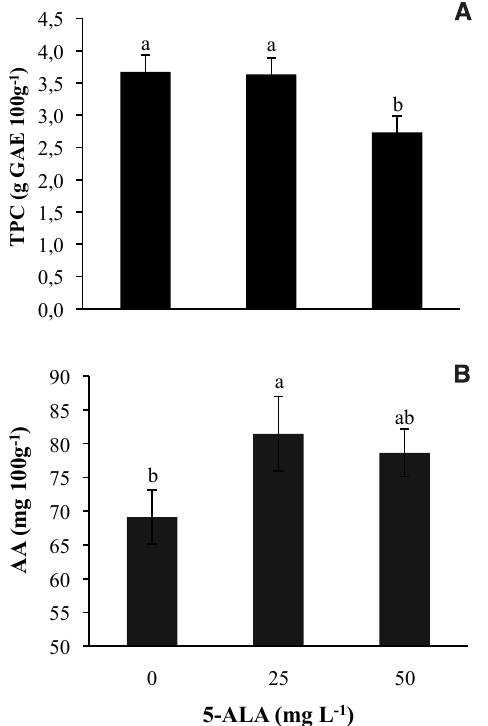
Fig. 2: The effects of different 5-ALA treatments on total phenolics (TP) (A) and ascorbic acid (AA) contents (B) in the leaves of Portulaca oleracea . Means marked by the same letter are not significantly different according to DMRT at P ≤0.05. Error bars represent standard